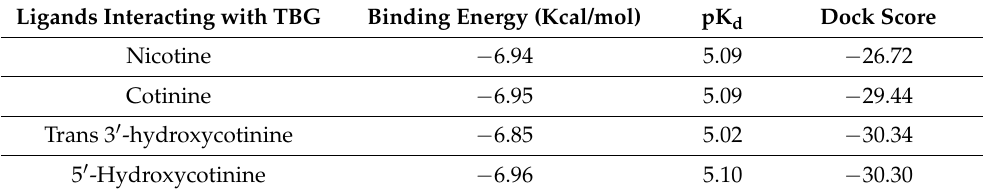
Table 6. The binding strength scores for nicotine and its metabolites in complex with thyroxine- binding globulin (TBG). The ‘K d ’ denotes the dissociation constant. The binding energy and pK d or − log (K d ) values were calculated using X-Score. Lower (more negative) binding energy or Dock/Grid score and higher dissociation constant denote better